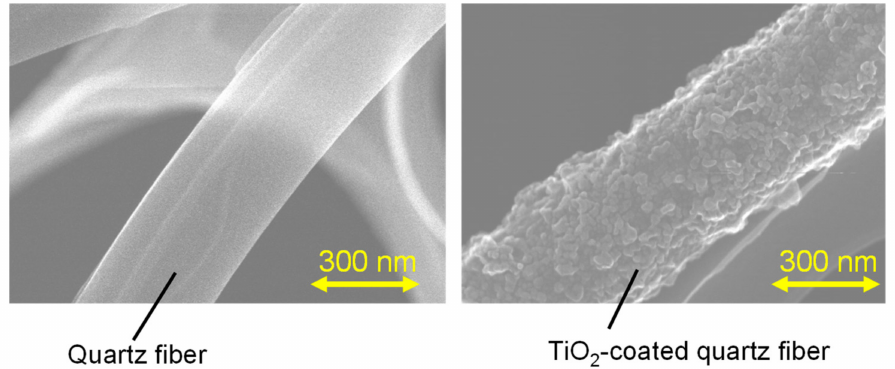
Figure 4. SEM images of a piece of fiber of the quartz and TiO 2 filters.